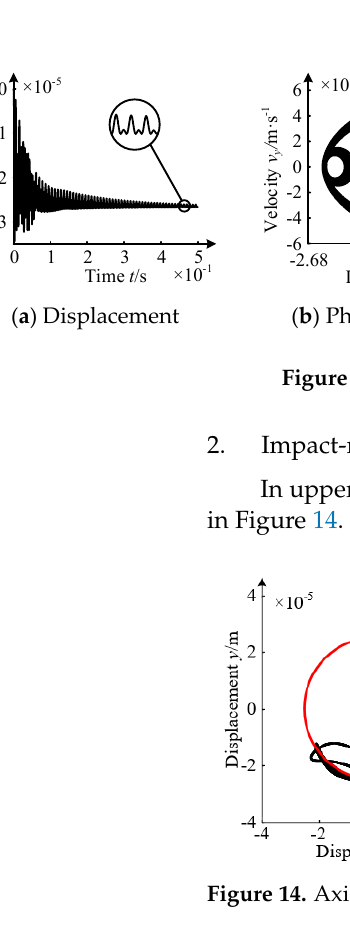
Similarly, the impact-rubbing phenomenon of the rotor can be divided into the bouncing stage and eddy stage, when the upper unit fails. When the rotor falls directly on the inner ring of the ball bearing, it bounces and collides firstly and then vortexes repeatedly forward/backward. Similarly, the rotor displacement, phase trajectory, rubbing force, and electromagnetic force were extracted, as shown in Figure 15.